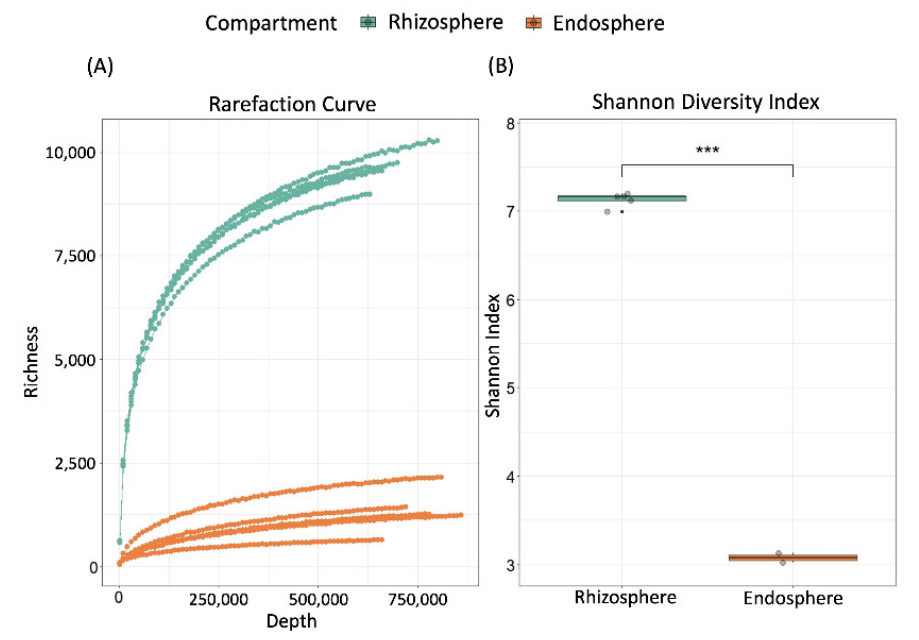
Figure 1. Alpha diversity of the bacterial microbiota in the endosphere and rhizosphere of common bean ( P. vulgaris ) grown in situ in the open field. ( A ) Rarefaction curves of the numbers of operational taxonomic units (OTUs) observed in the rhizosphere (green-cyan) and endosphere (orange) samples were calculated individually for each sample at an increment from the lowest depth (1000 reads) to the highest depth (approx. 1 million reads), each point represents the mean of three mathematical replicates. ( B ) Average Shannon diversity ( H’ ) per compartment, asterisks *** indicate a statistically significant difference between compartments ( p < 0.001, Welch Two Sample t -test, n = 5 biologically independent replicates).